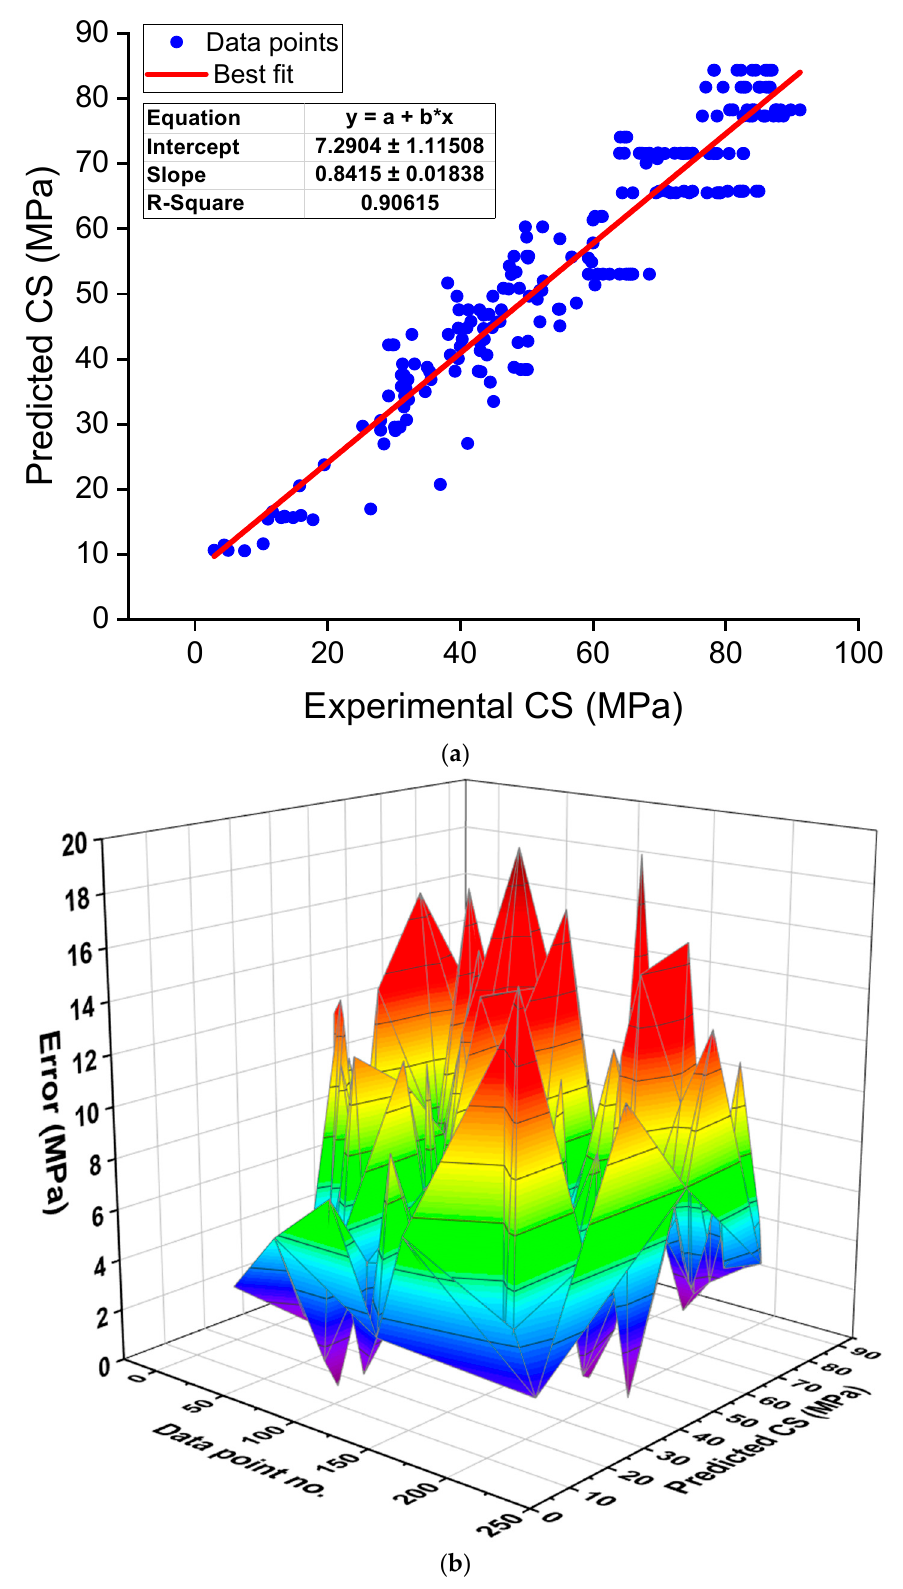
Figure 7. Regression model for CS: ( a ) correlation between actual and predicted results; ( b ) distribution of predicted and error values.